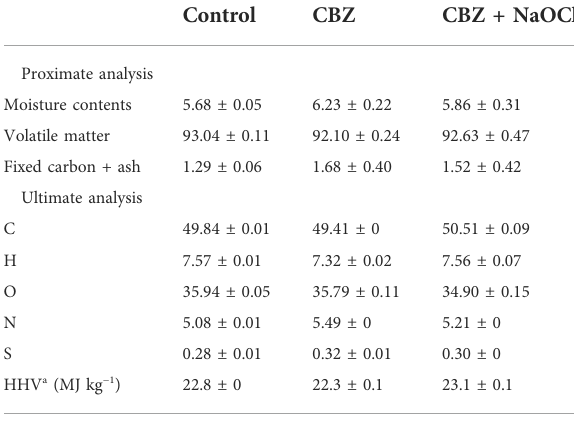
TABLE 1 Proximate and ultimate analyses of residual microalgal biomass.